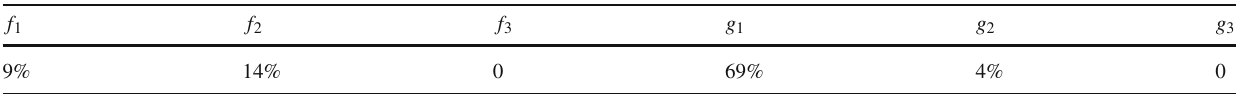
Table 20 The uncertainties of the decay widths of (cid:2) ++ cc → (cid:6) + c l + ν l caused by those of the form factors in Eq. (44). The central value of the decay width is 4 . 94 × 10 − 15 GeV f 1 f